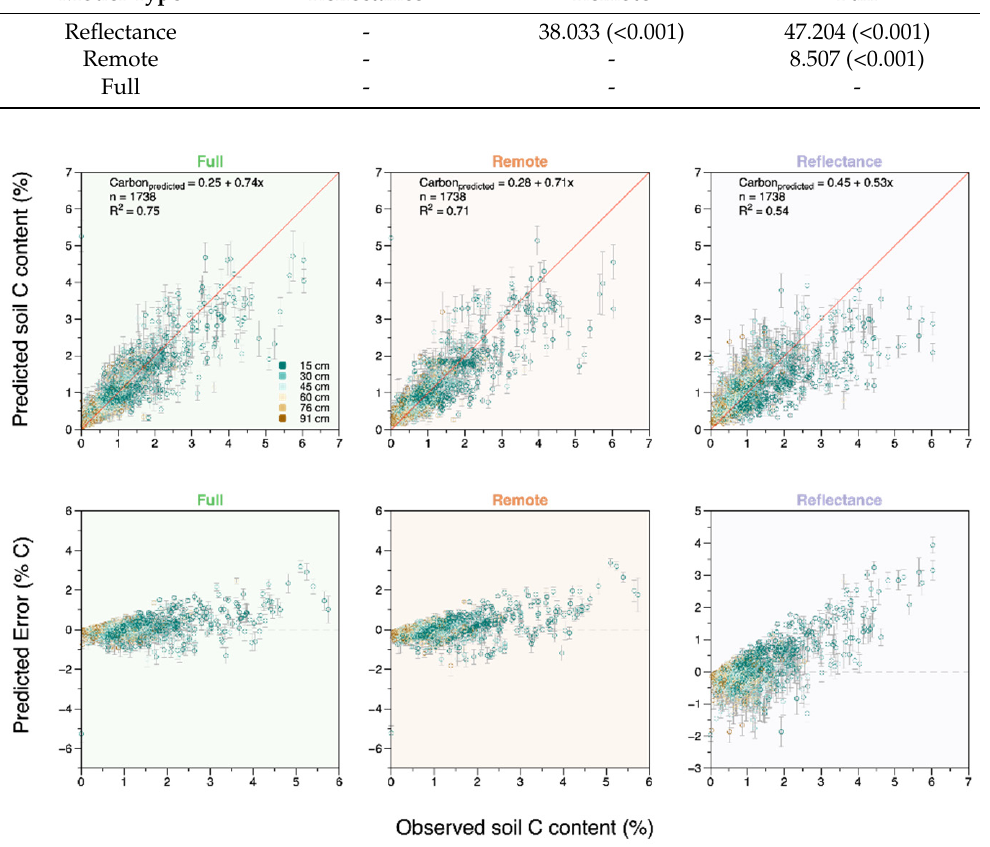
Figure 4. Model performance measured as Mean Absolute Error (MAE) ( a ), coefficient of determi- nation (R 2 ) ( b ), and Root Mean Square Error (RMSE) ( c ) across model types ( n = 1738). Raincloud plots adjacent (right) to each boxplot depict the histogram of raw data points and the frequency of different binned observations. Model bars in each boxplot represent the median value of 100 train/test splits for the corresponding model by depth combination; outer edges of the boxes repre- sent the 25 and 75% percentiles; whiskers represent 1.5× the interquartile range, and points represent outlying values greater than 1.5× the interquartile range from soils collected from nineteen partici- pating ranches encompassing approximately 17,347 ha in the Southern Great Plains ecoregion of the United States.